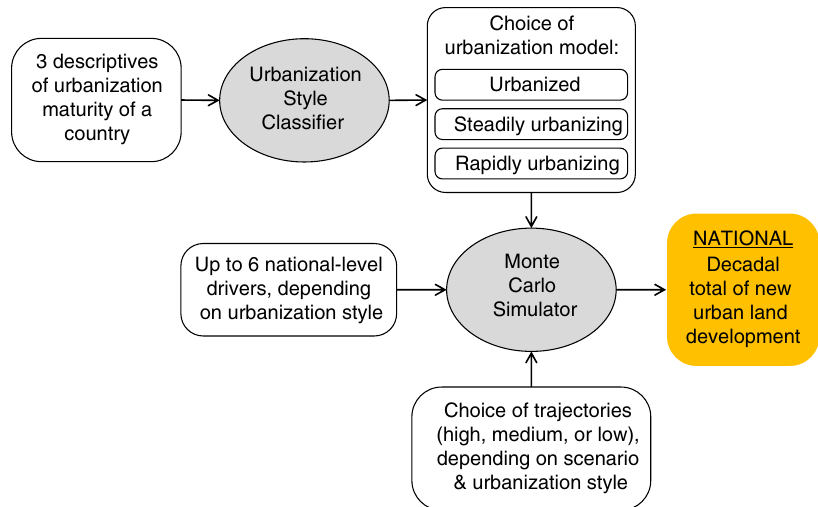
Fig. 7 Decadal update routine of the Country-Level Urban Buildup Scenario (CLUBS) model. This fl owchart shows how CLUBS estimates the national total amount of new urban land development for one country over one decade. The process repeats for all countries, and iterates over time decade by decade. (Gray ovals — model parts; white squares — input data and intermediate output; orange square — fi nal